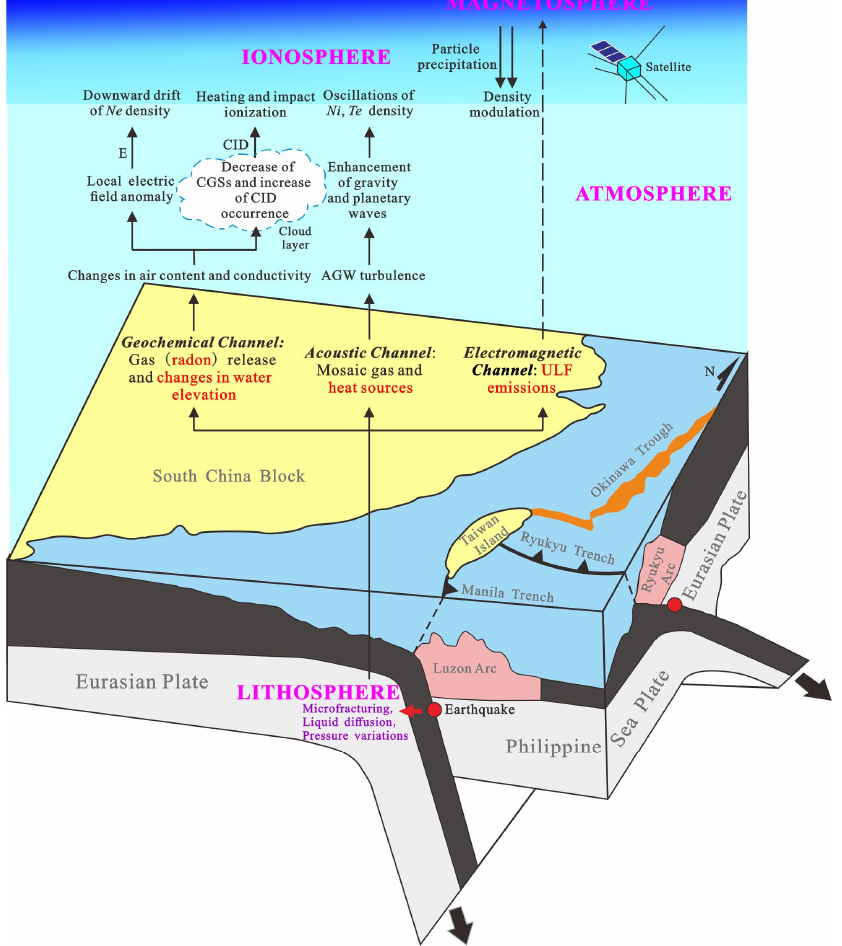
Figure 6. The 3D model of lithosphere-atmosphere-ionosphere coupling in Taiwan and the surrounding region.